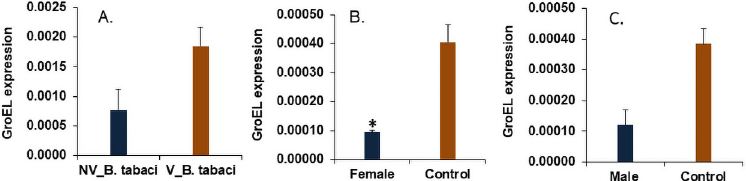
Fig 4. Relative expression of GroEL protein gene in A. Non-viruliferous and Viruliferous Bemisia tabaci B. Tetraccycline fed females C. Tetracycline fed males. The expression level was normalized with β -tubulin as housekeeping gene. The error bars represent the standard deviation (n = 3) and � represents significant differences among male and female whiteflies (P � 0.05, Student’s t-test).